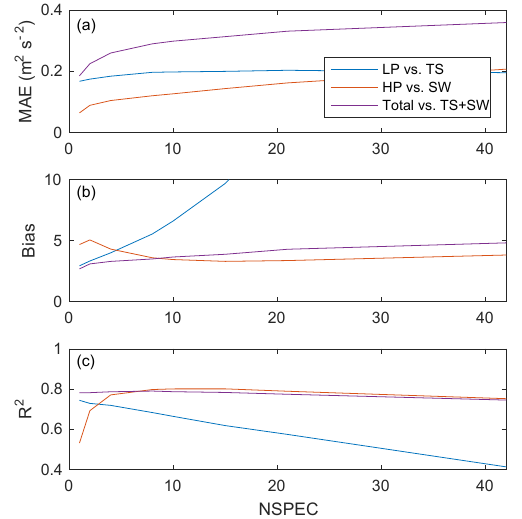
Figure 6. (a) Mean absolute error, (b) normalized bias (WPR mi- nus sonic, normalized by sonic), and (c) correlation of determina- tion between sets of variance measurements: low-passed variance from sonic anemometers (LP) versus WPR time series of vertical velocity (TS) (blue); high-passed variance from sonic anemometers (HP) versus variance from WPR spectral widths (SW) (red); total variance from sonic anemometers versus the sum of TS and SW from the WPR (purple). Data from all four overlapping heights of the 449MHz WPR and the sonic anemometers and all data from 1 March to 30 April 2015 are